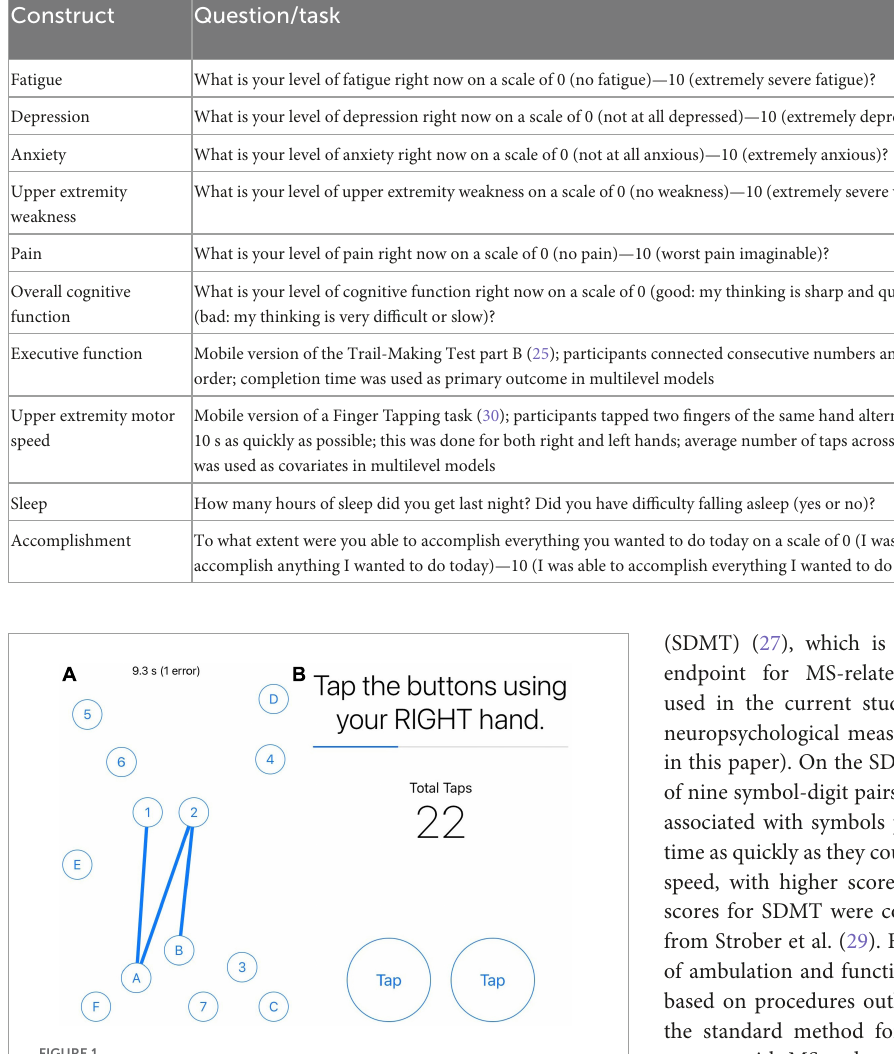
FIGURE1 Screenshots of mTMT-B and finger tapping tasks. Panel (A) is screenshot of the mobile Trail-Making Test part B (mTMT-B) task. Panel (B) is a screenshot of the mobile finger tapping task. Users performed one trial with their right hand, followed by a second with their left